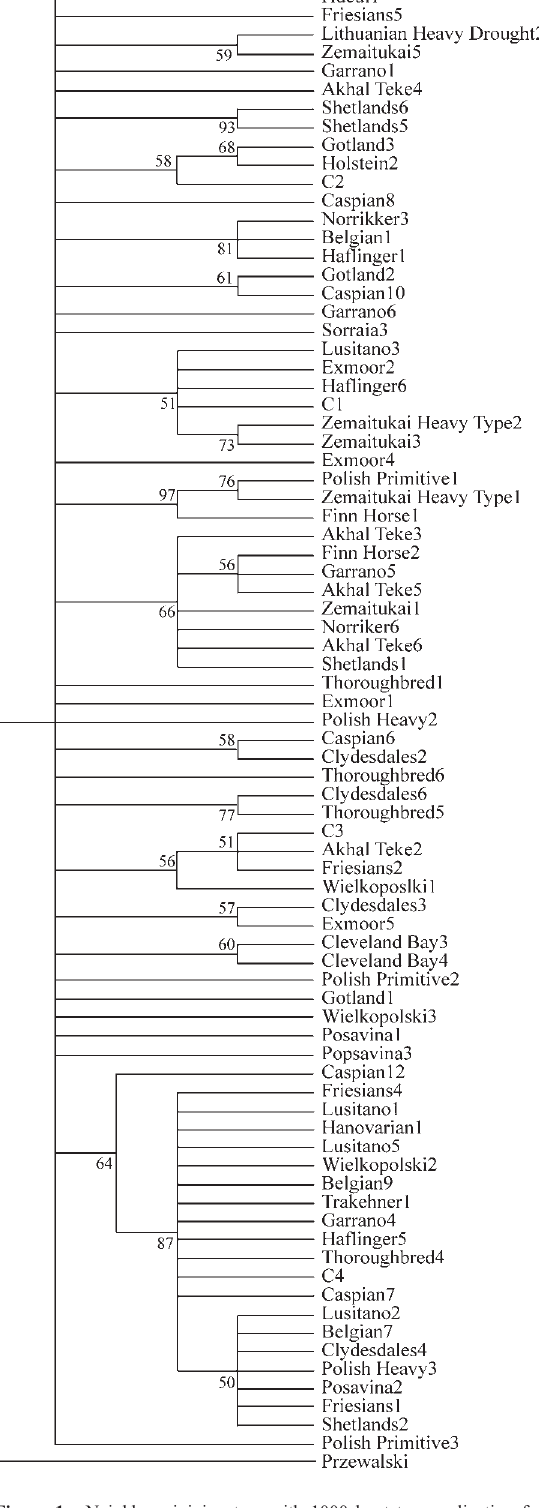
Figure 1 - Neighbour-joining tree with 1000 bootstrap replication for Lithuanian and other European horse